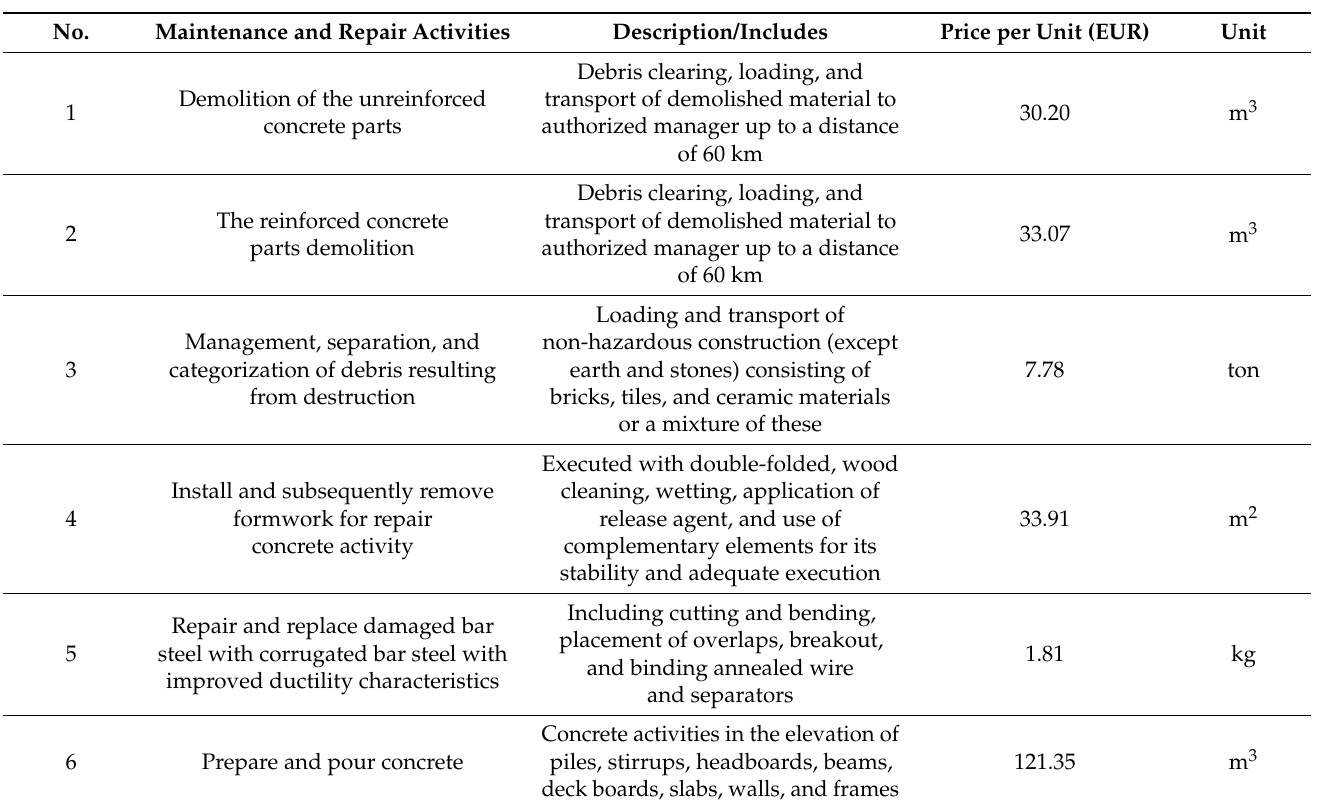
Table 3. Repair activity cost (EUR) according to Spain data code (2022) [65] for the concrete and coastal Arosa